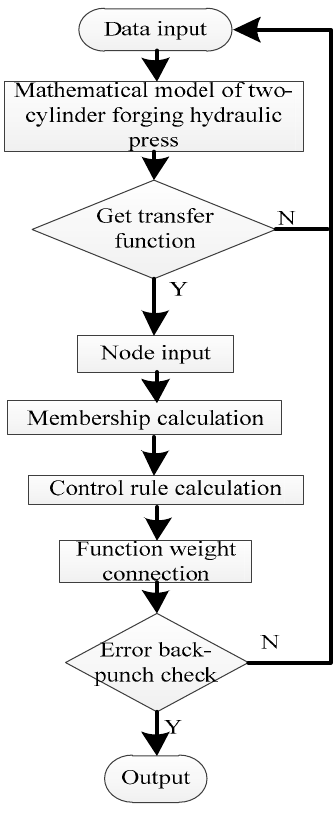
Figure 1. Algorithmic overall control flow.